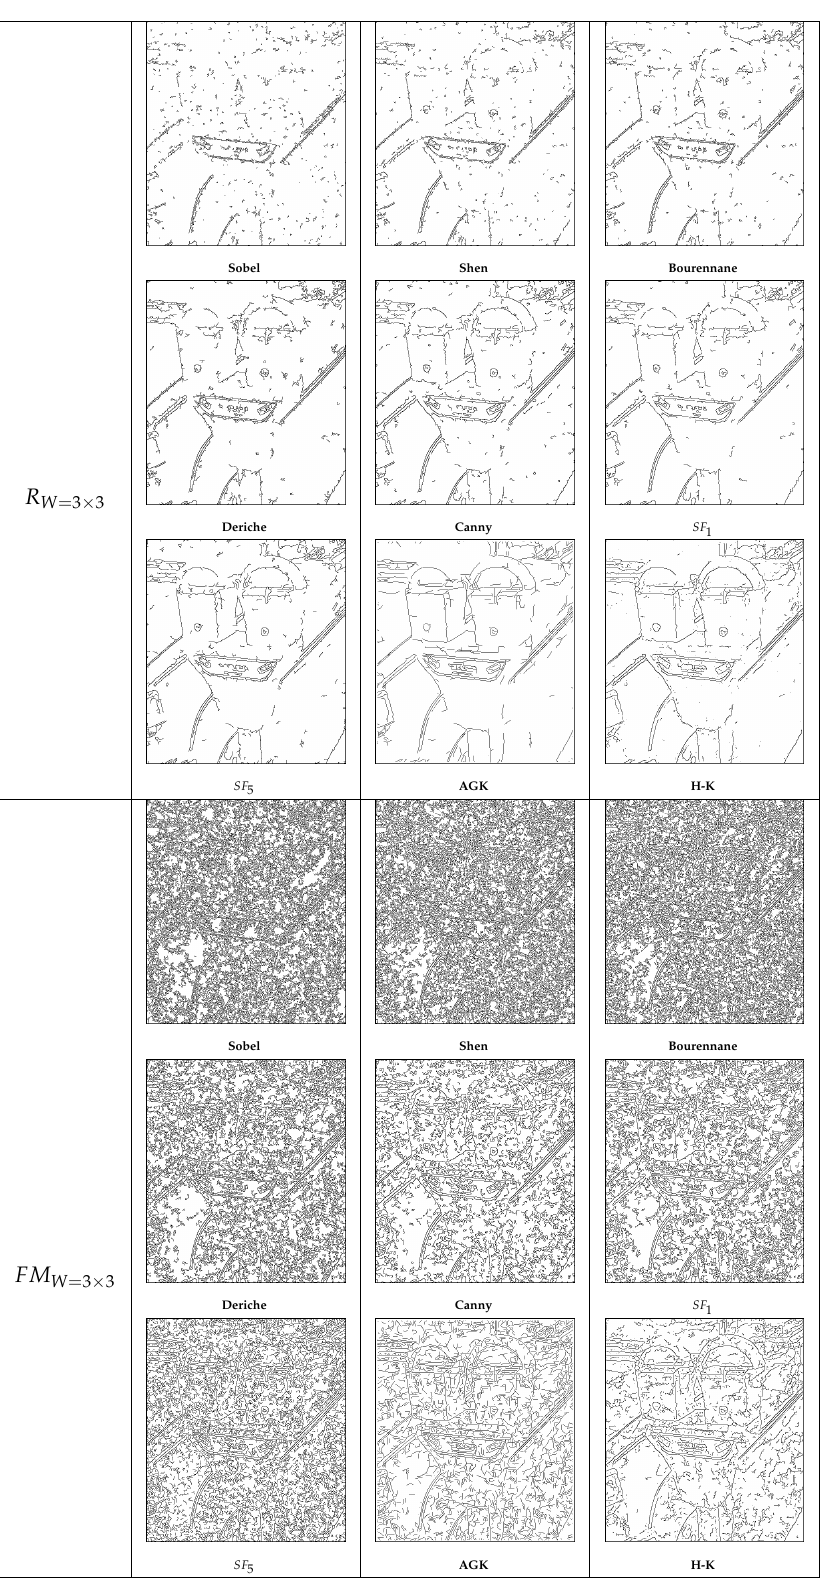
Figure 39. Ideal segmentations for several edge detectors on image parkingmeter, PSNR = 14